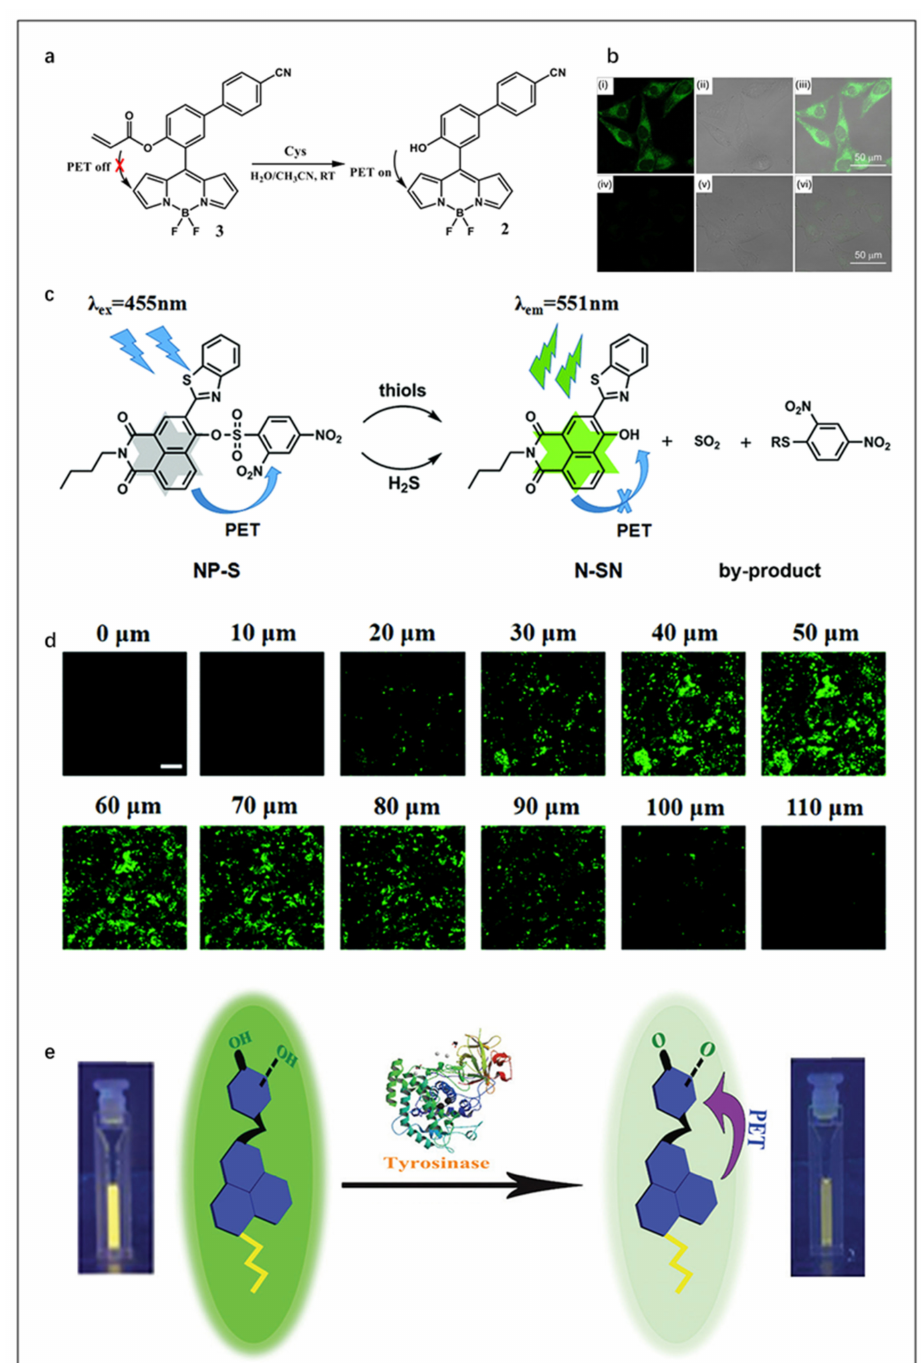
Figure 3. ( a ) The concept of a probe for Cys detection. ( b ) Confocal microscopy images of Cys detection in live A375 cells using probe. ( i ) Cells incubated with probe (20 µ M) for 30 min at 37 ◦ C, ( ii ) bright field of ( i ), ( iii ) merge of ( i , ii ), ( iv ) probe-treated A375 cells further incubated with Cys (1 mM) for 30 min, ( v ) bright field of ( iv ), ( vi ) merge of ( iv , v ). Reproduced with permission from Ref.